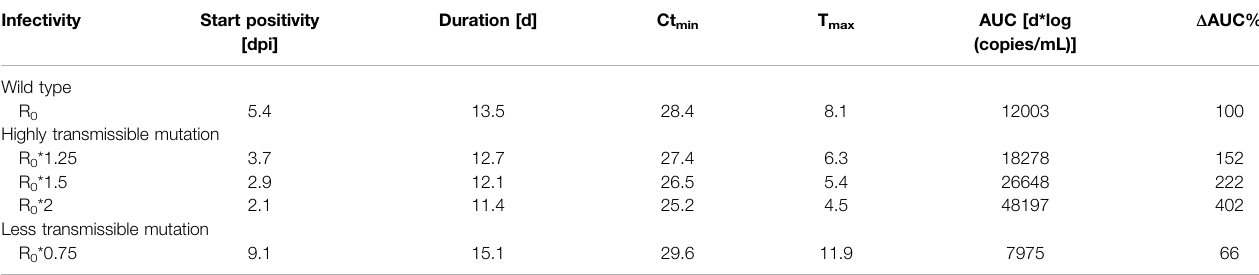
TABLE2| Simulatedwithin-hostviralkineticsatdifferentlevelsofcellularinfectivity(givenasmultiplesofR 0 =3.79).Abbreviations:dayspostinfection(dpi);day(d);minimum serial cycle threshold values (Ct min ); time of Ct min (T max ); area under the curve (AUC); percentage difference in AUC compared to wild-type ( Δ AUC%).